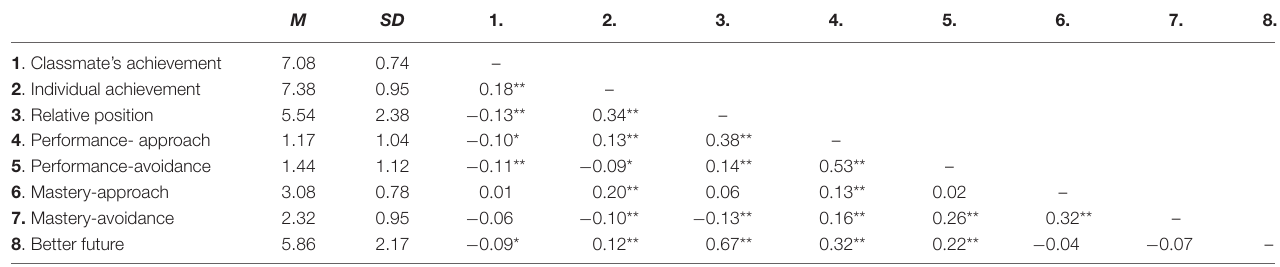
TABLE 1 | Descriptive statistics and bivariate